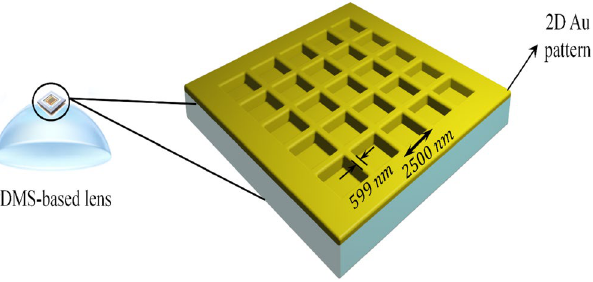
Figure 3. A schematic array of the simulated 2D plasmonic contact lens based on